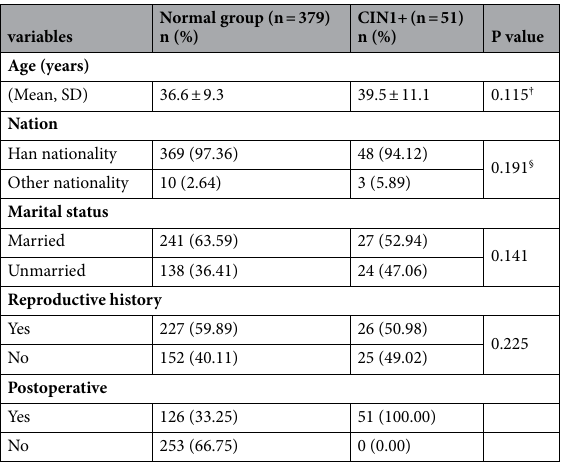
Table 1. Socio-demographic characteristics among participants. † Is a non-parametric test. § Is Fisher’s exact probability method, the rest are all using chi-square test; the lesions group includes patients with CIN I, CIN II, CIN III and cervical cancer. The normal group is the patients with normal cervical pathology or negative TCT and HPV results.